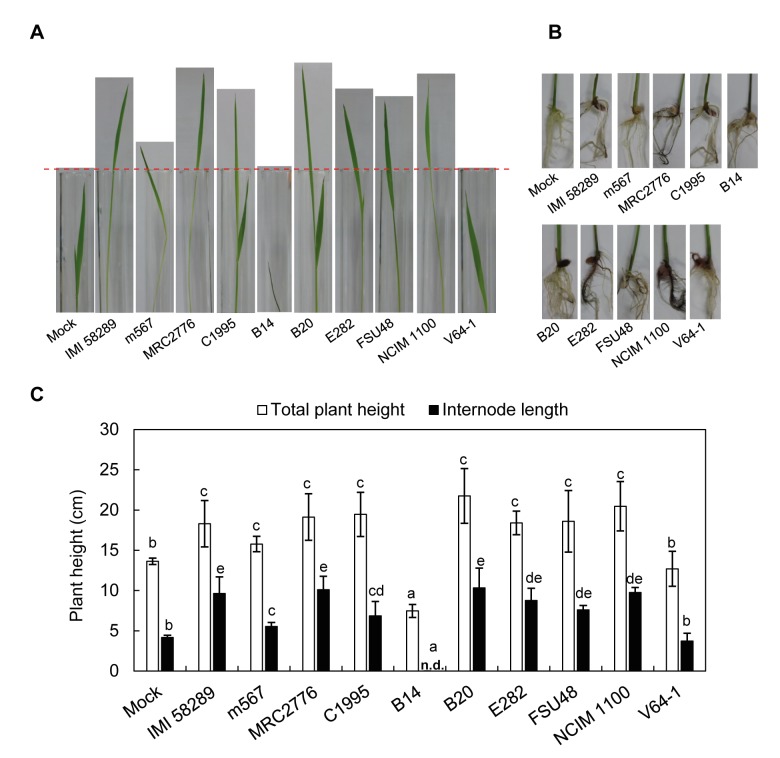
Pathogenicity assay of the F. fujikuroi and F. oxysporum isolates.(A) Symptoms in the rice stems that were inoculated with the fungal isolates and water only (control). The uppermost stem level of the rice seedling with control treatment is indicated by a thin dotted bar. (B) Symptoms in the rice roots after pathogen infection. (C) The plant heights and internode lengths of pathogen-infected rice seedling at 6 dpi. Error bars show standard deviations. The same letter above bars indicates no significant difference. n.d., not detected.